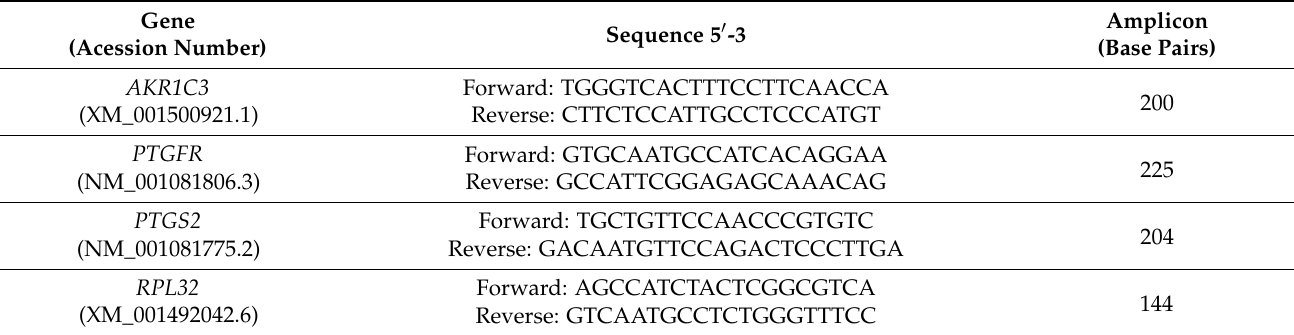
Table 1. Primer sequences used in real time PCR